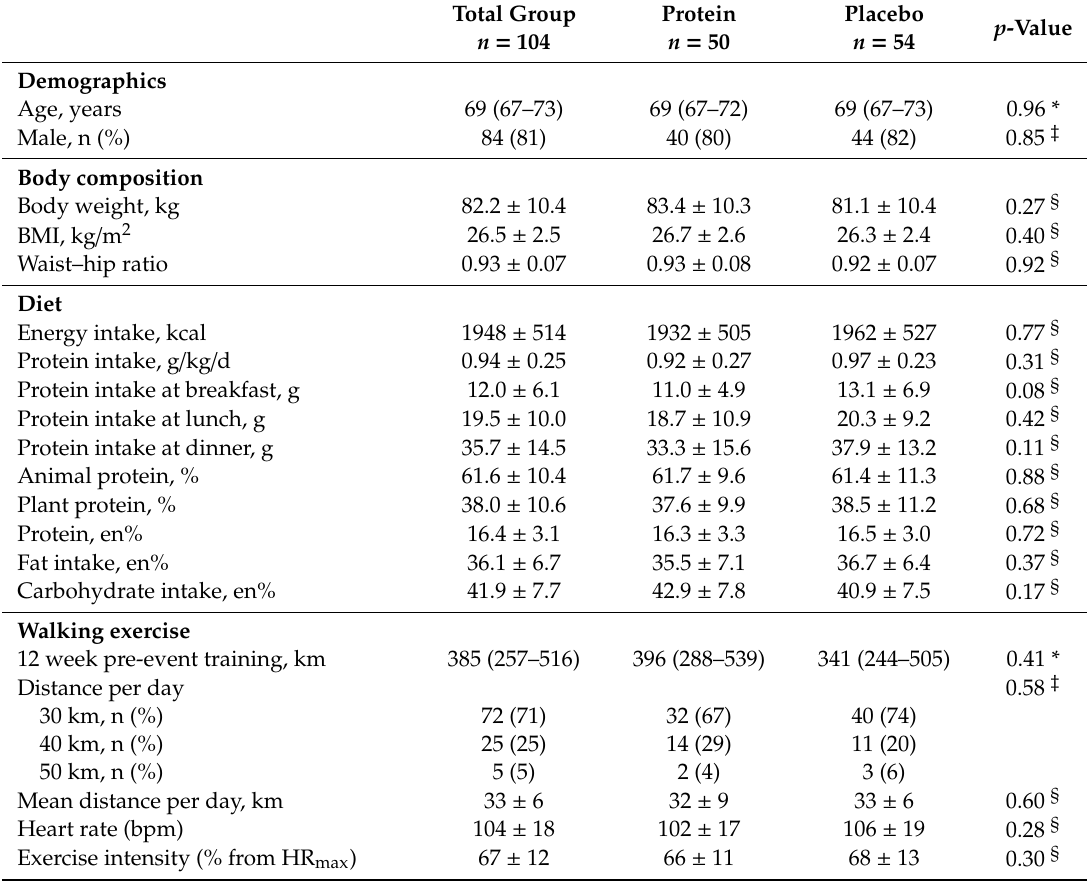
Table 2. Baseline characteristics of subjects in the protein and placebo groups.